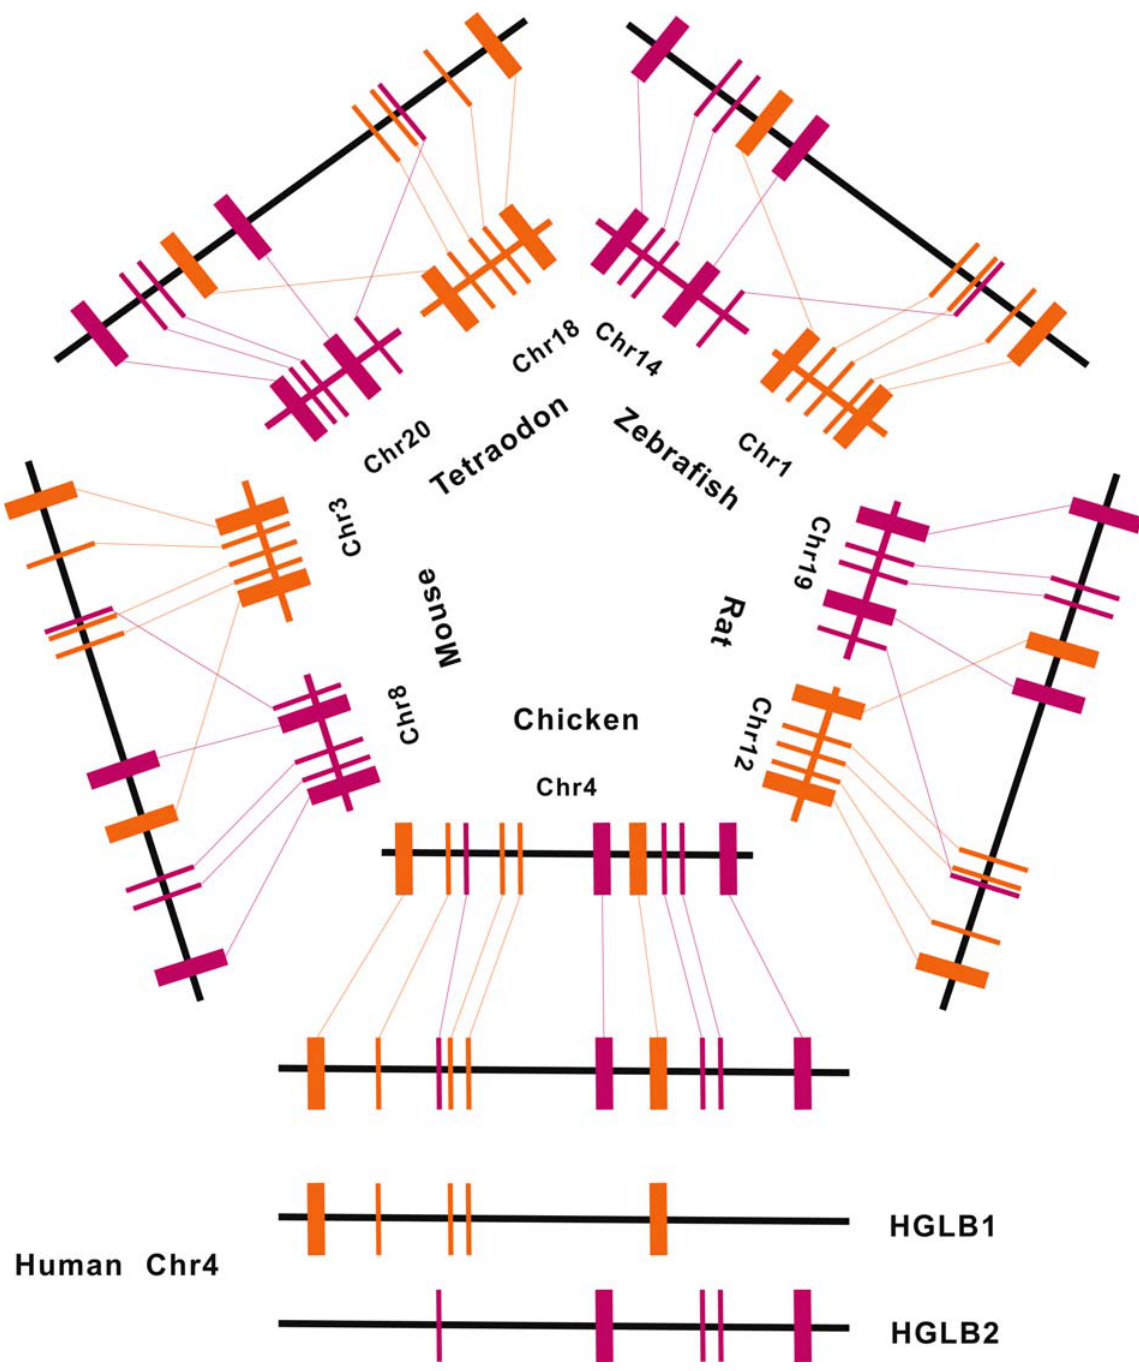
Figure 3. A sketch map of interlaced HGLBs. Two HGLBs interlaced each other on human chromosome 4. The two HGLBs reside in two different chromosomes in the mouse, rat, zebrafish and tetraodon genomes respectively. The conserved associations between HCEs and genes are not restricted to elements in relative proximity on the genome. HCEs belonging to the same cluster are divided into two HCE blocks, which are linked with two different sets of genes. (To compact the figure, several genes and HCEs are ignored and the size of the associated genomic region is not adjusted to the real scale. Rectangles represent genes while bars stand for HCEs. Lines link ortholgous sequence elements, and are labeled with the same color for the same HGLB block.) observed in the comparison between the human and the other four that the distances for the portion of HCE-gene pairs with larger absolute distances are also well conserved (Table S8). genomes. For the human-mouse comparison, the median |RDD| values for HCE-gene pairs with larger absolute distances were at a The RDD values for HCE-gene pairs are distributed closer to level similar to those with shorter absolute distances, indicating zero than RDD values for gene-gene and exon-exon pairs in the